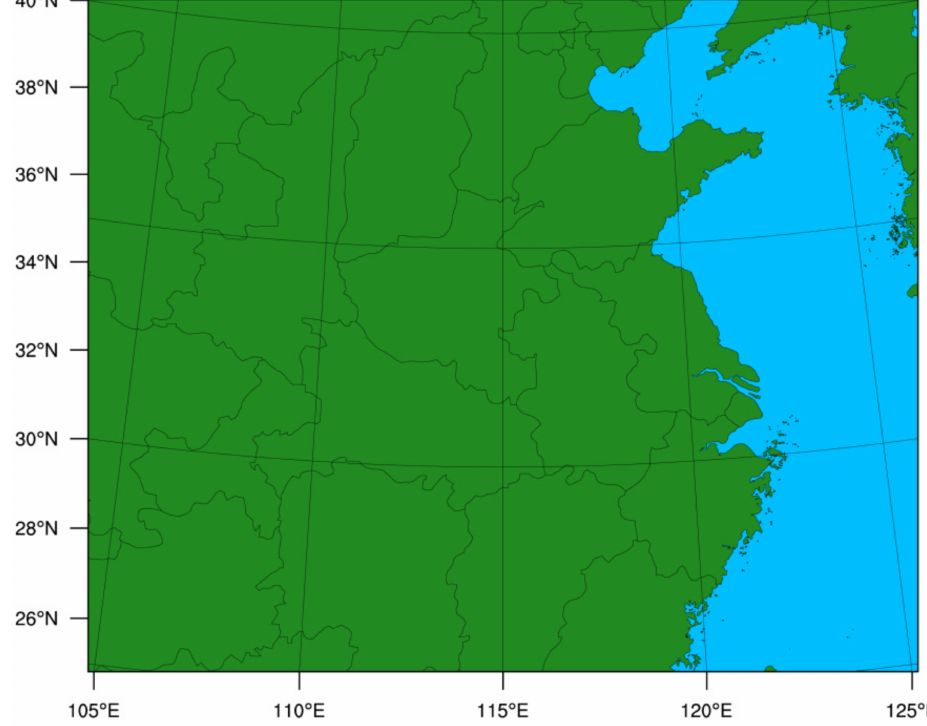
Figure 1. The simulation domain of the